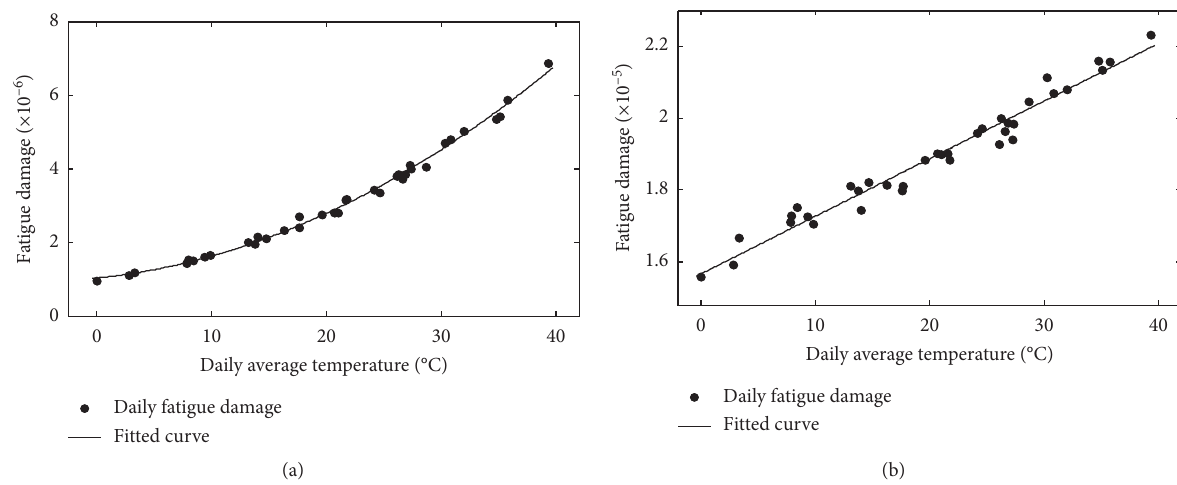
Figure 14: The correlation between D and T : (a) the rib-to-deck joint and (b) the rib-to-rib